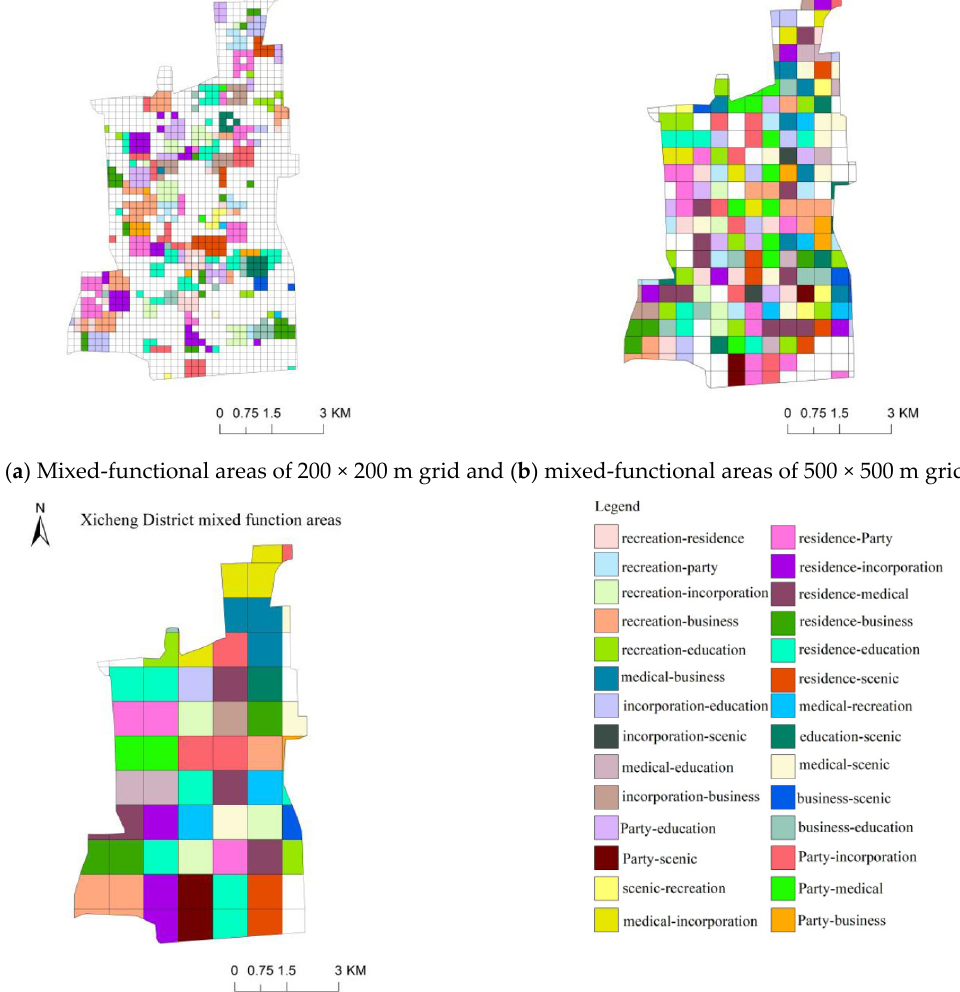
Figure 9. Mixed-functional areas in the Xicheng District.